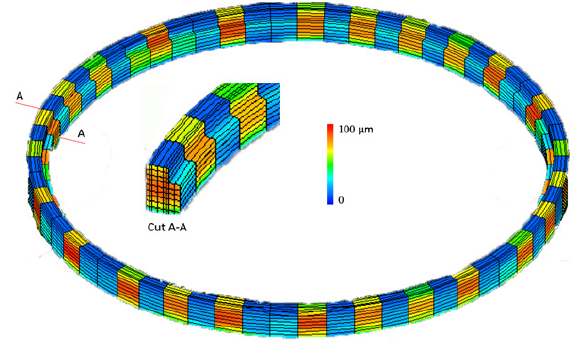
Figure 22. Cracking pattern (with opening) on the gusset obtained with the model 5 days after its